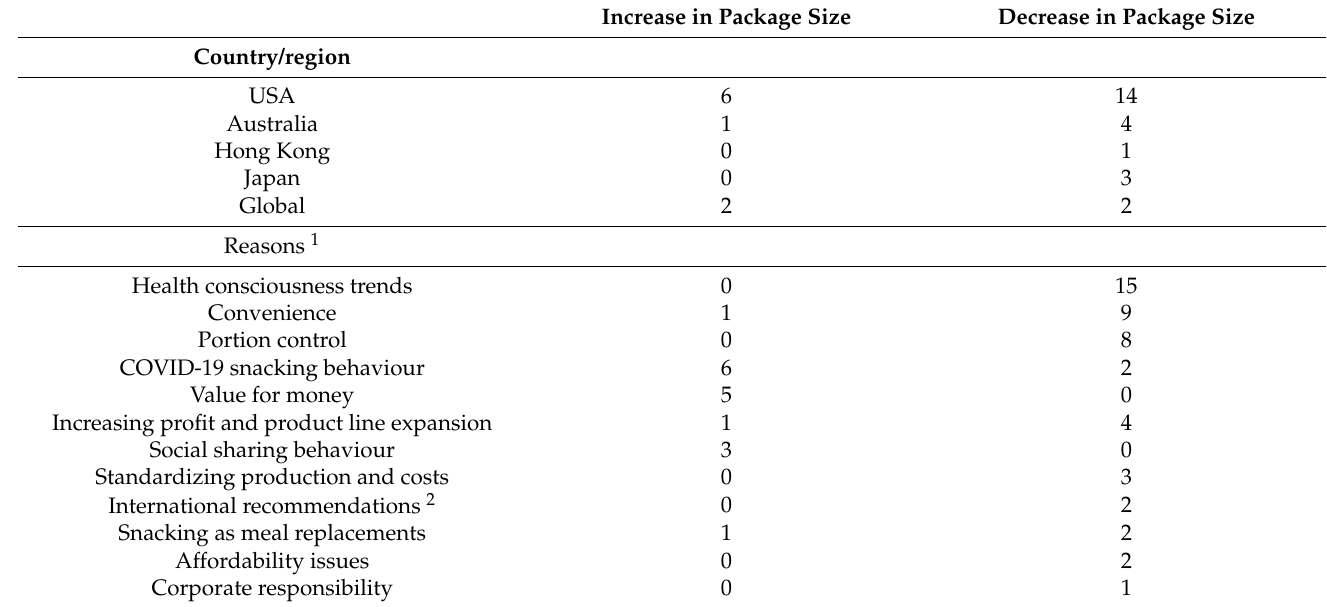
Table 2 . Industry reasons for changes in savoury snack package sizes .